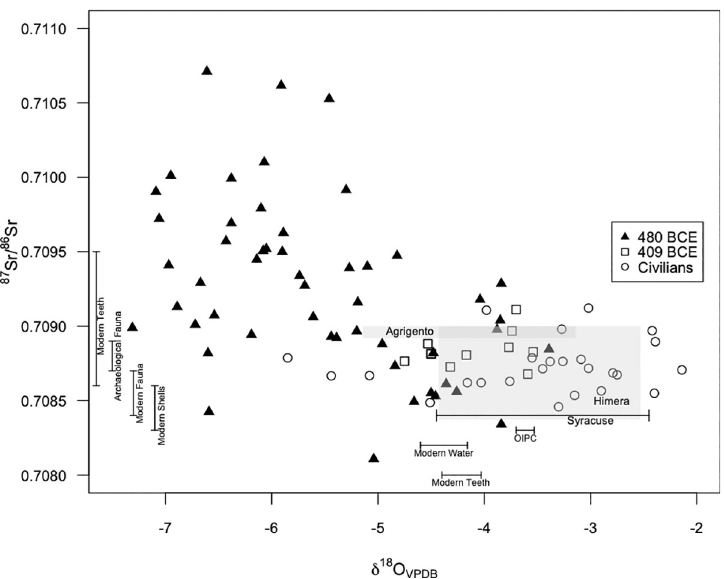
Fig 4. 87 Sr/ 86 Sr and δ 18 O data for soldiers from 480 BCE and 409 BCE, and civilians. Gray shaded areas represent the measured baseline values for Agrigento and Himera. The bar representing Syracuse’s expected δ 18 O values is placed close to the 87 Sr/ 86 Sr values that can be expected for Syracuse, based on its underlying geology (0.70800– 0.70900). Bars at the base of the figure represent mean/stdev δ 18 O values of measured modern water, measured modern enamel, and estimated precipitation at Himera. Bars on the left of the figure represent mean/stdev 87 Sr/ 86 Sr values of measured modern teeth and fauna, archaeological fauna, and shells at Himera.